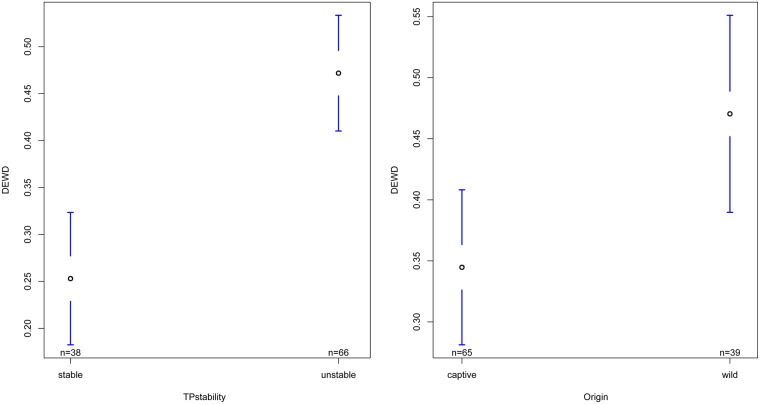
Confidence interval plots of DEWD and both significant fixed factors, Origin and TPstability.Mean deviation from edge weight disparity (±95% CI).